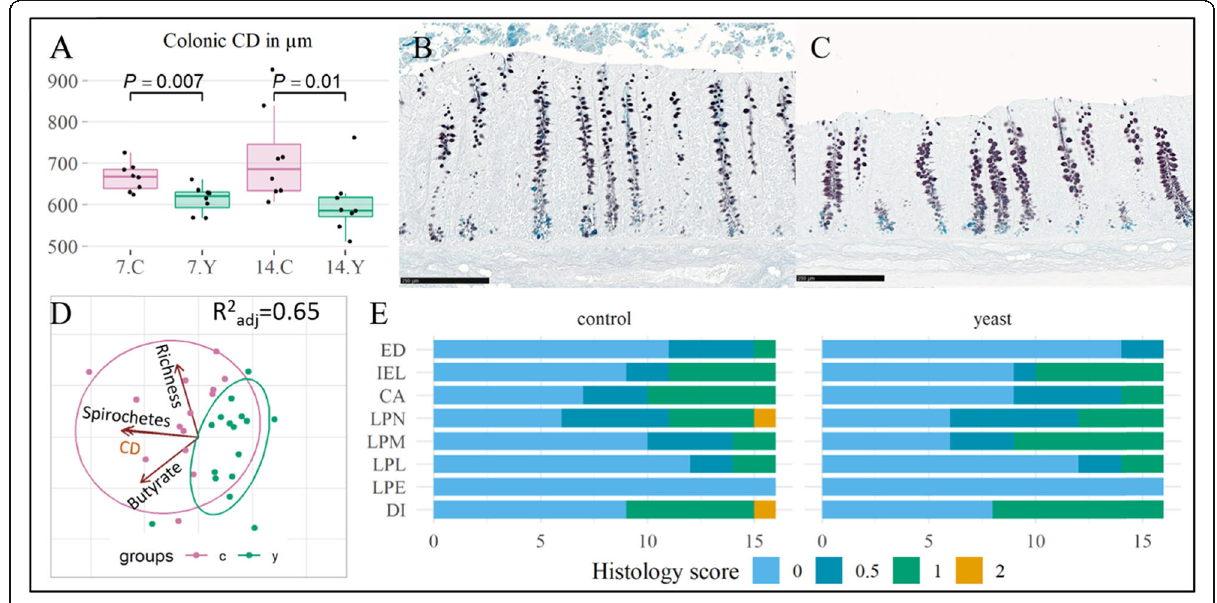
Fig. 3 Gut health parameters in postweaning pigs fed with control and yeast diets. Panel a Boxplot showing comparison of colonic crypt depth (CD) measurements between the control and yeast group at day 7 PW and day 14 PW coloured and denoted by the diet and day ( 7.C controls day 7 PW pink , 7.Y yeast day 7 PW dark cyan , 14.C controls day 14 PW pink, 14.Y yeast day 14 PW dark cyan ). MWW test p-values are provided above the boxes. Panel b Representative section of colon mucosal crypts from the control group at day 14 PW (HID-AB stain, scale bar 250 μ m). Panel c Representative section of colon mucosal crypts from the yeast group at day 14 PW (HID-AB stain, scale bar 250 μ m). Panel d : Principal coordinate analysis illustrating contribution of Spirochetes relative abundance, colonic butyrate concentration, and 16S rRNA gene richness to the colonic crypt depth. The individual observations and the correlation circles are coloured by the diet (controls pink , yeast dark cyan ). The adjusted R 2 is given at the right top corner. Panel e : Histopathological assessment of the colon mucosa, evaluating epithelial damage (ED), number of intraepithelial lymphocytes (IELs), presence of crypt abscess (CA), and infiltration of leukocytes neutrophils (N), macrophages (M), lymphocytes (L), eosinophils (E), in addition the number of piglets that were diagnosed with a very mild or mild colitis (DI). The horizontal stacked bar plot shows the number of animals with none (0), very mild (1), mild (2), or moderate histopathological